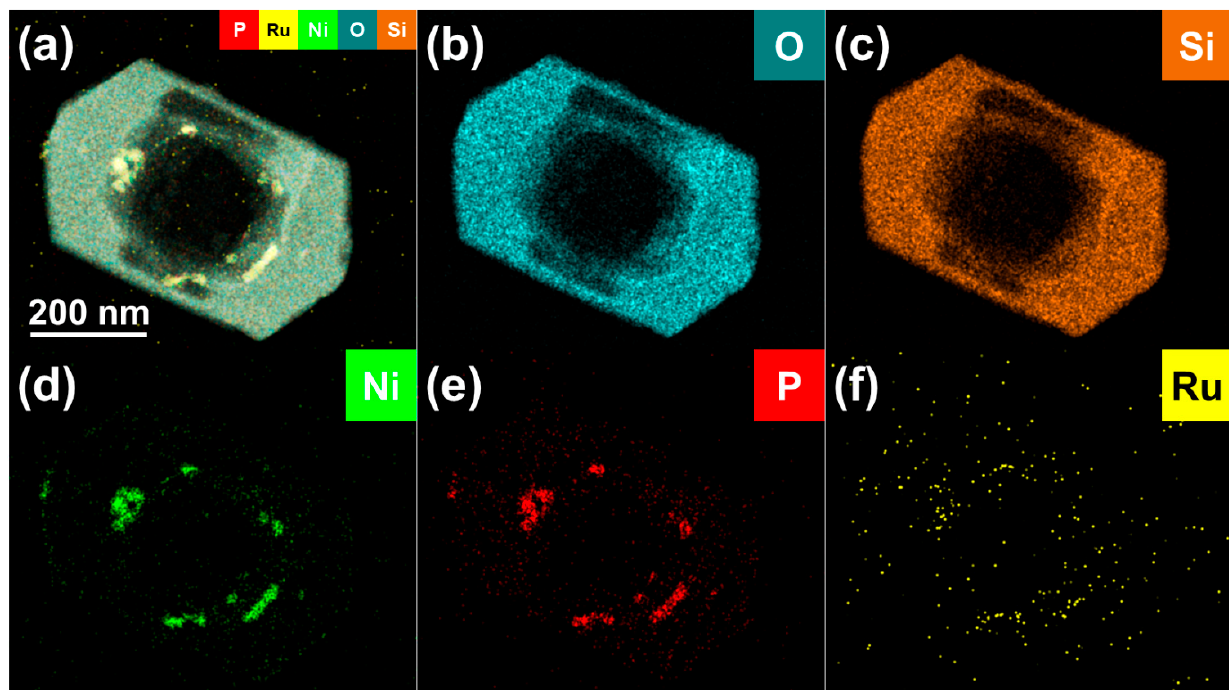
Figure 3. ( a – f ) TEM mapping of Ru-Ni 12 P 5 /S-1 5 . The surface chemical states of Ru, Ni, and P in Ru-Ni 12 P 5 /S-1 5 are presented in Figure 4. In the Ni 12 P 5 phase, four apparent Ni (2p 3/2 ) peaks centered at 862.3, 858.5, 856.5 and 853.1 eV were assigned to satellite, Ni 3+ , Ni 2+ , and Ni δ + species [27,28], respectively, as displayed in Figure 4a. Similar to amorphous RuP x , two Ru (3p 3/2 ) peaks with binding energies of 466.1 and 462.6 eV, respectively, were attributed to Ru 4+ and Ru δ + species [29] (Figure 4b). Previous studies found that these metal species with a very small charge ( δ ≈ 0) in metallic phosphides, especially the Ru δ + species, facilitates hydrogen activation [26,30]. Notably, no apparent electron transfer between Ru and Ni species was detected in Ru-Ni metal phosphide, confirming that Ru-Ni 12 P 5 is a composite.